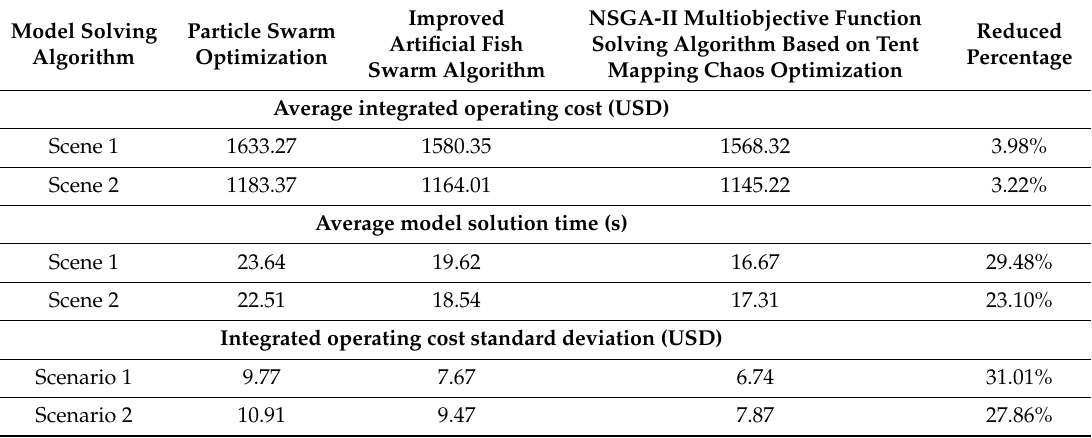
Table 4. Comparisons of solving indicators of integrated energy system optimal economic dispatch model based on three